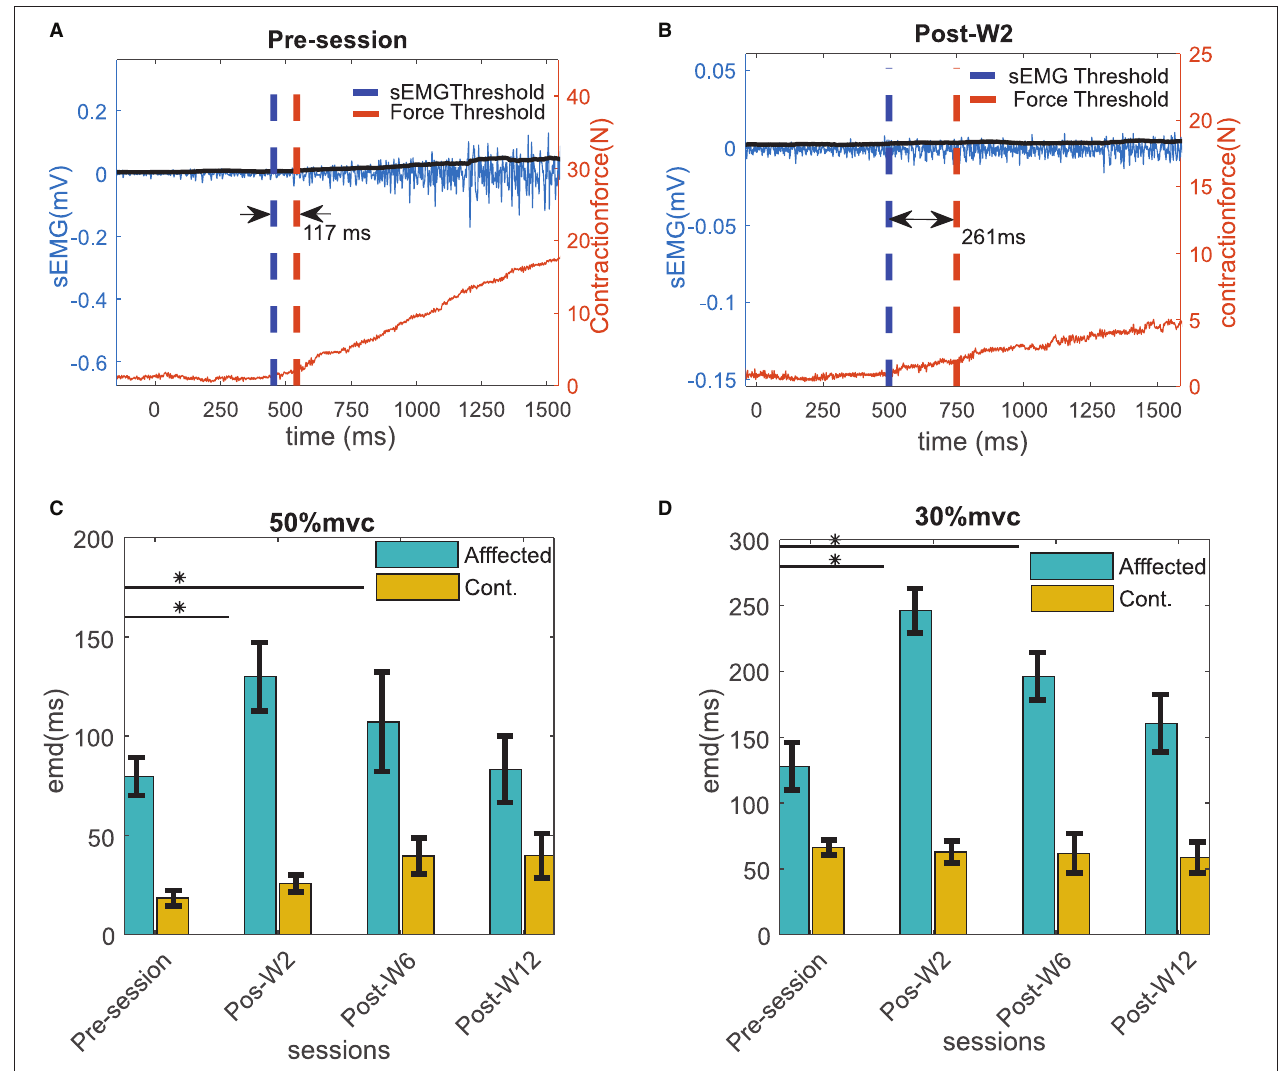
FIGURE 5 | Example of the EMD in the affected side calculated for the subject B2 (A) before and (B) at Post-W2 after the BT injection shown with the raw sEMG (blue trace with left y scale), rms sEMG (black trace with left y scale), and the force (red trace with right y scale) at 30% contraction level. The thresholds of sEMG and force are marked with blue and red vertical dotted line. (C) The electromechanical delays calculated for all the subjects across different sessions at 50 % MVC and (D) 30 % MVC contraction trials. The column height represents the mean, while the error bar represents the standard deviation of the ZC values at the session for the subjects. Statistically significant difference of the EMD values in the affected side across sessions ( p < 0.05) is indicated by